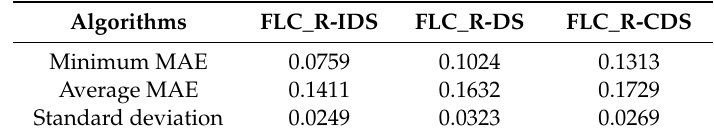
Figure 12. Comparison of the path tracking best performances of the proposed FLC_R-IDS, FLC_R- DS, and FLC_R-CDS methods in test environment 2. Table 5. Comparison of 30 controllers and their MAE values of various existing models in test environment 2.